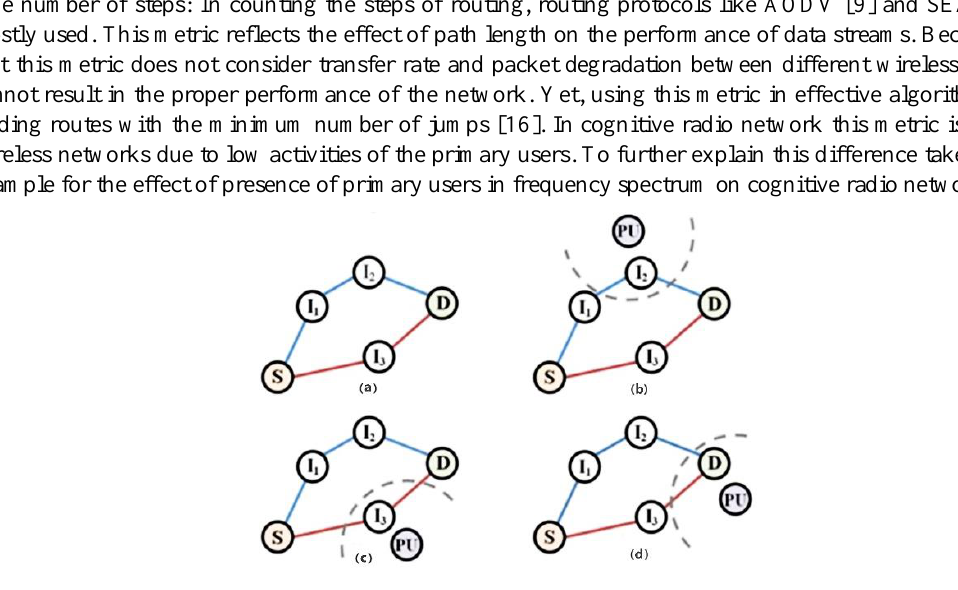
Figure 5. The use of number of steps metric in routing cognitive radio networks